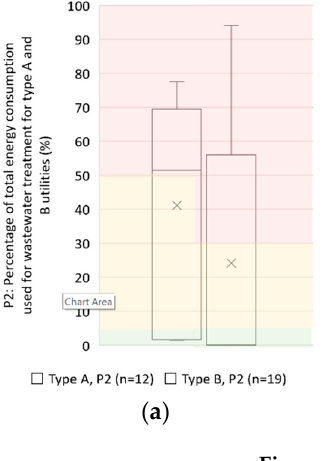
Figure 6. Results of evaluation at utility level for ( a ) percentage of total energy consumption used for WW treatment (P2) for type A (left) and type B utilities (right), ( b ) specific GHG emissions associated with pumped volume (P12), and ( c ) specific GHG emissions associated with wastewater treated volume (P13).